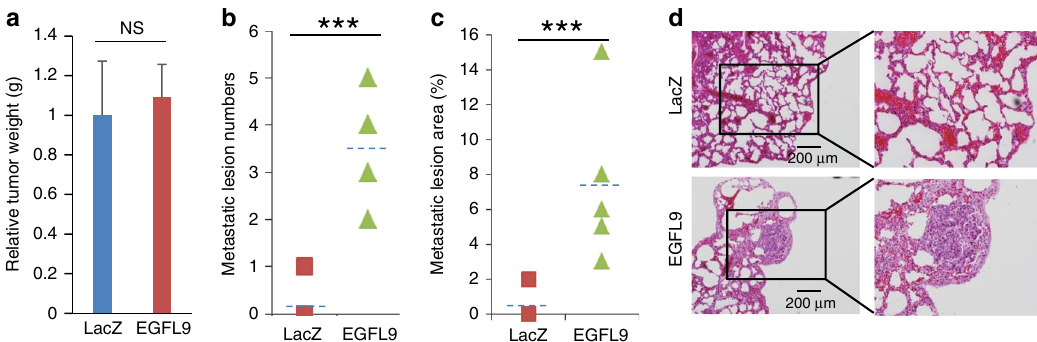
Fig. 3 Overexpression of EGFL9 promotes distant tumor metastasis in vivo. a Overexpression of EGFL9 in EpRas cells did not change tumor weight. EpRas/ LacZ cells serve as a control model (NS, P = 0.59). b Quanti fi cation of metastatic lesions in two groups of tumors derived from EpRas/LacZ and EpRas/ EGFL9 cells implanted in NCR nu/nu mice. Average metastatic lesion numbers from fi ve serial sections in each tumor were compared. *** P < 0.001. P values were determined by unpaired two-tailed t -test. c Quanti fi cation of metastasis by lesion area in two groups of tumors derived from EpRas/LacZ and EpRas/EGFL9 cells implanted in NCR nu/nu mice. Relative metastatic lesion areas (tumor lesion/lung section) from sections with the highest metastatic lesion number in each tumor were compared. *** P < 0.001 . P values were determined by unpaired two-tailed t -test. d Representative H&E staining pictures of lung sections from mice. IHC results showed signi fi cant metastatic lesions in EGFL9 transfected EpRas cells (low panel) in comparison with EpRas transfected with LacZ (top panels). Magni fi cation: ×40 (left panels) and ×400 (right panels). Scale bar: 200